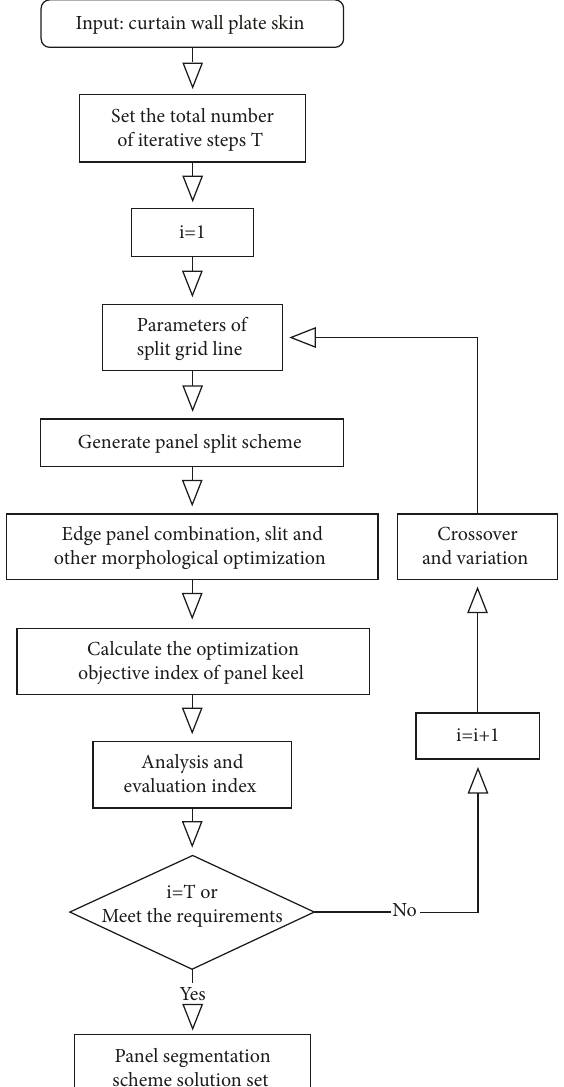
Figure 2: SPEA II multiobjective optimization